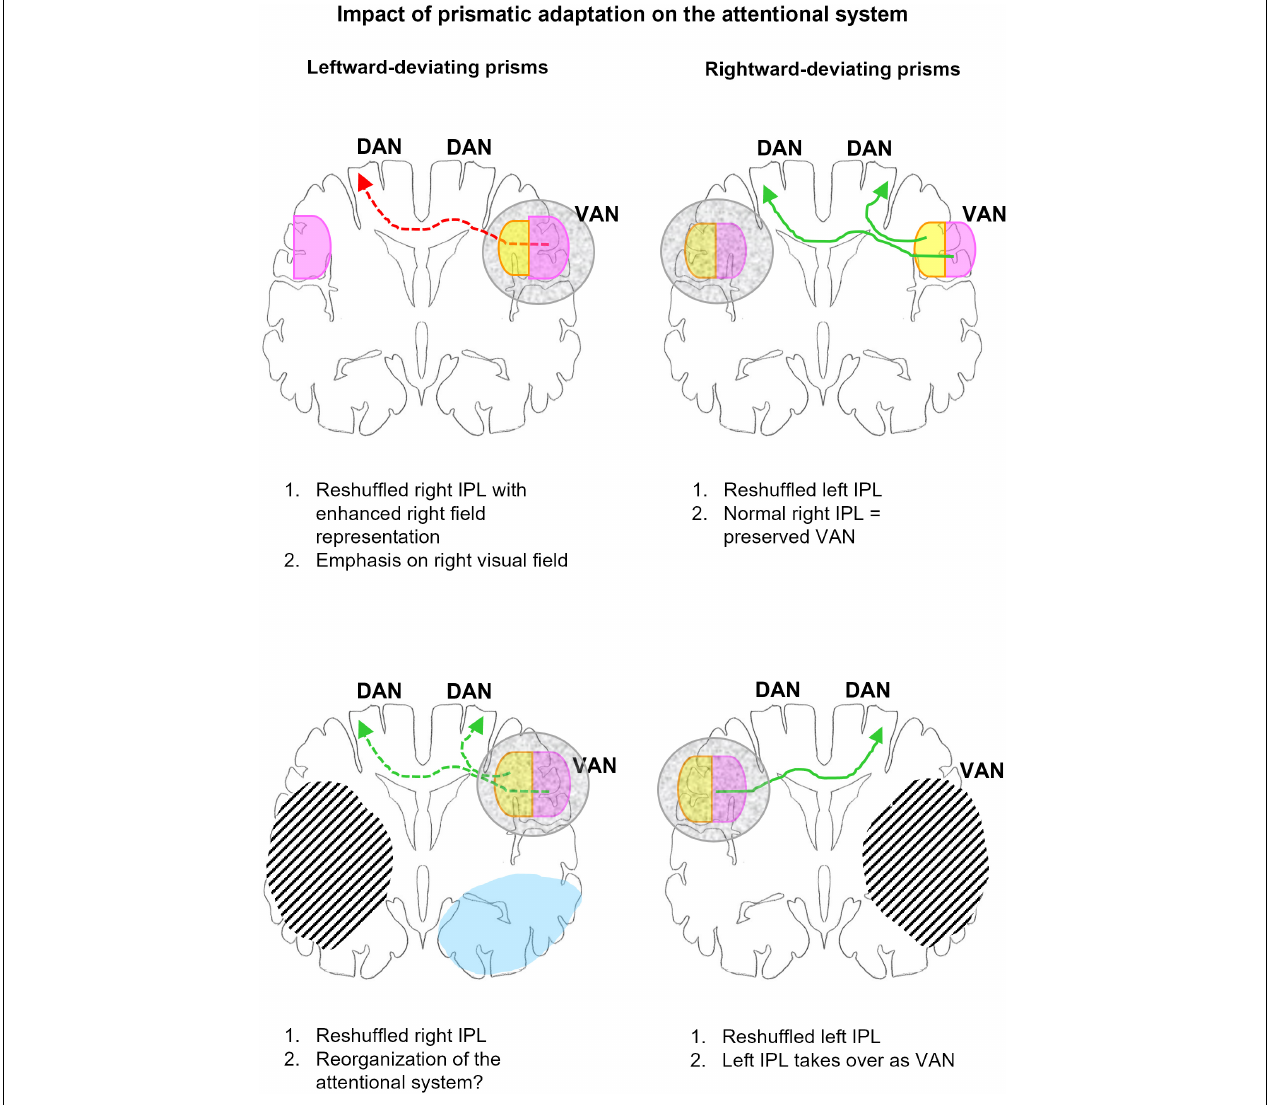
FIGURE 4 | Schematic representation of the impact of adaptation to left- (left column) and right-deviating prisms (right column) on the organization of the attentional network in normal subjects (top row) and patients with unilateral hemispheric lesions (bottom row). The outline represents a coronal section at the level of IPL, right hemisphere is to the right. Gray mottled overlay marks reshuffled IPL representations. Right space representation is in violet, left space in yellow. Green arrows indicate links relevant to correct or recovered function, red arrows those contributing to dysfunction. Arrows in full line mark links compatible with behavioral and/or imaging evidence, those in dashed line, hypotheses to be tested. Hatching represents lesions, blue, regions where L-PA downregulates activation by visual stimuli. Top : In normal subjects L-PA leads to the reshuffling of spatial representations within VAN, enhancing the ipsilateral space representation (Crottaz-Herbette et al., 2017b). The latter is likely to increase the activation of DAN in the left hemisphere. Both the relative dysfunction of the reshuffled VAN and increased activation of left DAN are likely to contribute to the neglect-like effects, which L-PA induces in normal subjects. R-PA leads in normal subjects to the reshuffling of spatial representations within left IPL, by enhancing the ipsilateral space representation (Crottaz-Herbette et al., 2014; Tissieres et al., 2018). Since VAN is preserved, the reshuffled left IPL is very likely not to impact attentional functions. Bottom : In patients with right-hemispheric lesions, R-PA leads to the reshuffling of spatial representations within left IPL, by enhancing the ipsilateral space representation (Crottaz-Herbette et al., 2017a). In the absence of a functional VAN, the left IPL takes over and drives DAN on either side. In patients with left-hemispheric lesions, L-PA reshuffles and changes partially spatial representations within VAN;